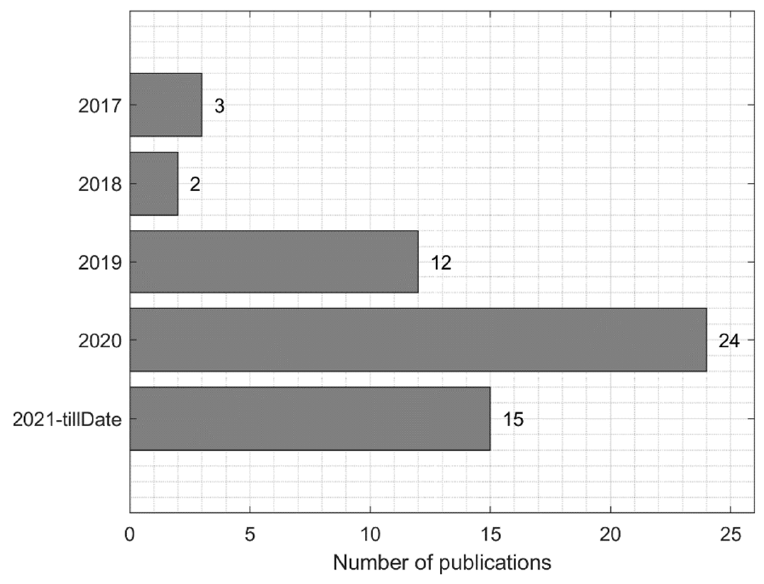
Figure 3. Number of publications year-wise.